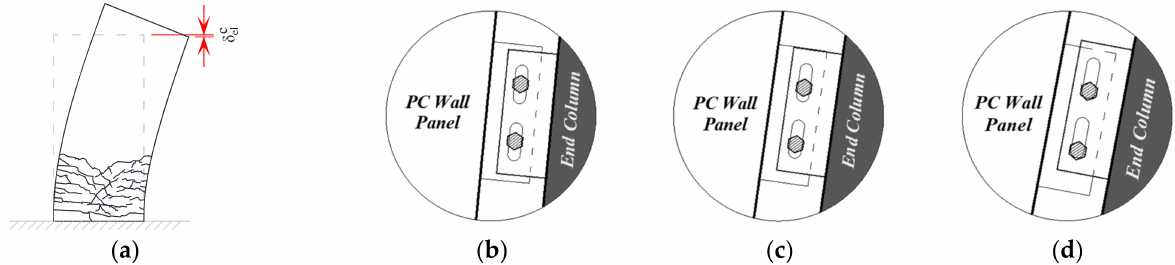
Figure 12. Vertical bearing of Compressive side (VC). ( a ) Longitudinal elongation of compressive side; ( b ) Before slip; ( c ) Slipping; ( d ) Bolt bearing.